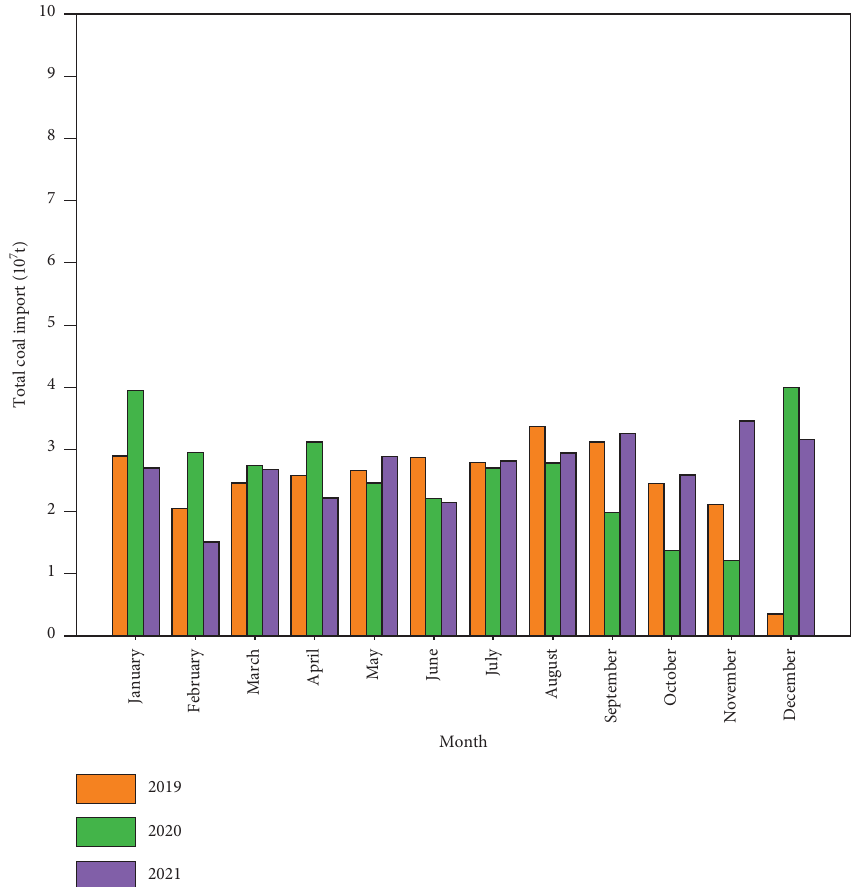
Figure 1: China’s total monthly coal imports from